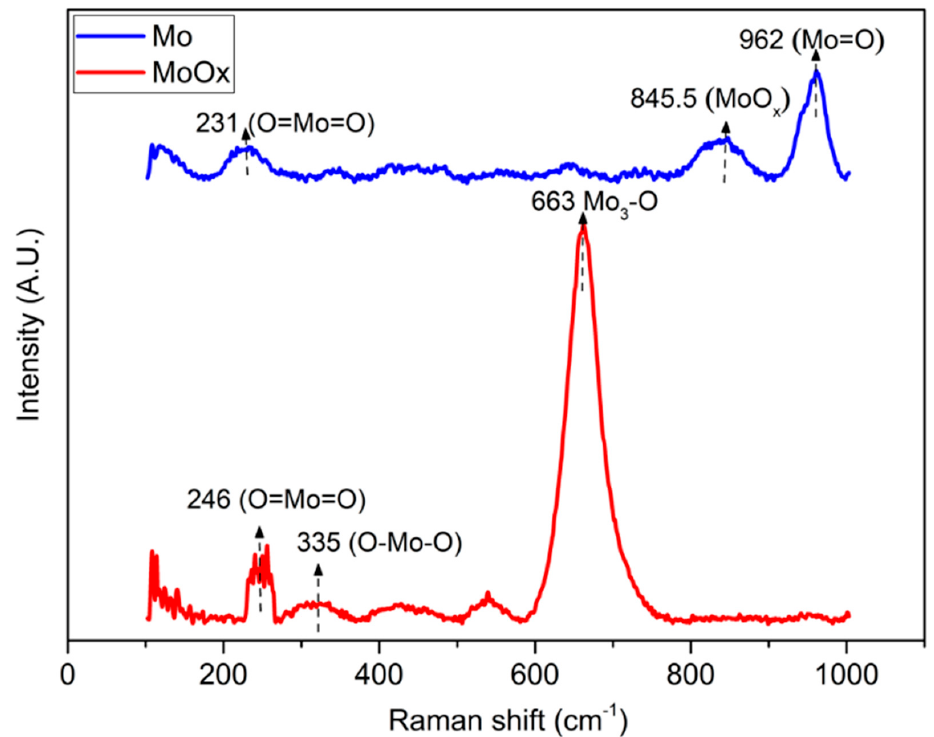
Figure 6. Raman shift of the as-deposited Mo, i.e., without post laser treatment showing the Mo deposited on the surface (this process is in vacuum and metallic Mo is expected); post deposition laser treated with 1.5 and 0.2 W showing the formation of oxides MoO x on the surface of the Mo-coated sample (this process is in air, and oxidation is expected).